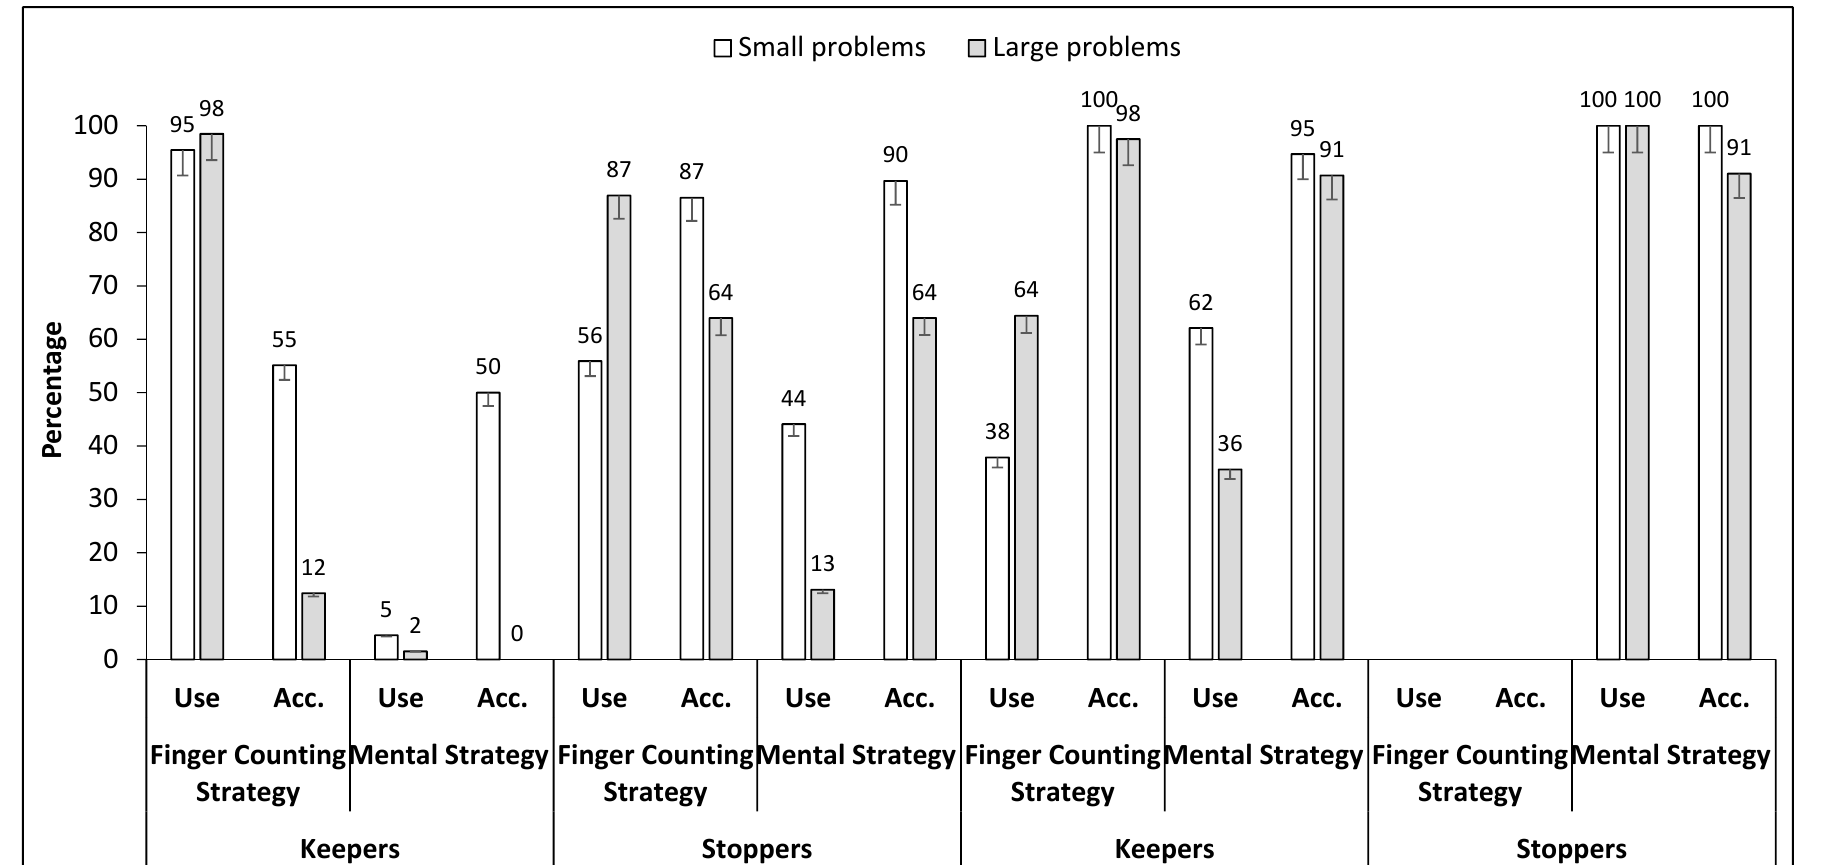
Figure 1. Percentage of finger and mental counting strategies and accuracy in Kindergarten and in Grade 2 in keepers and stoppers. Acc. for Accuracy = Correct answers.